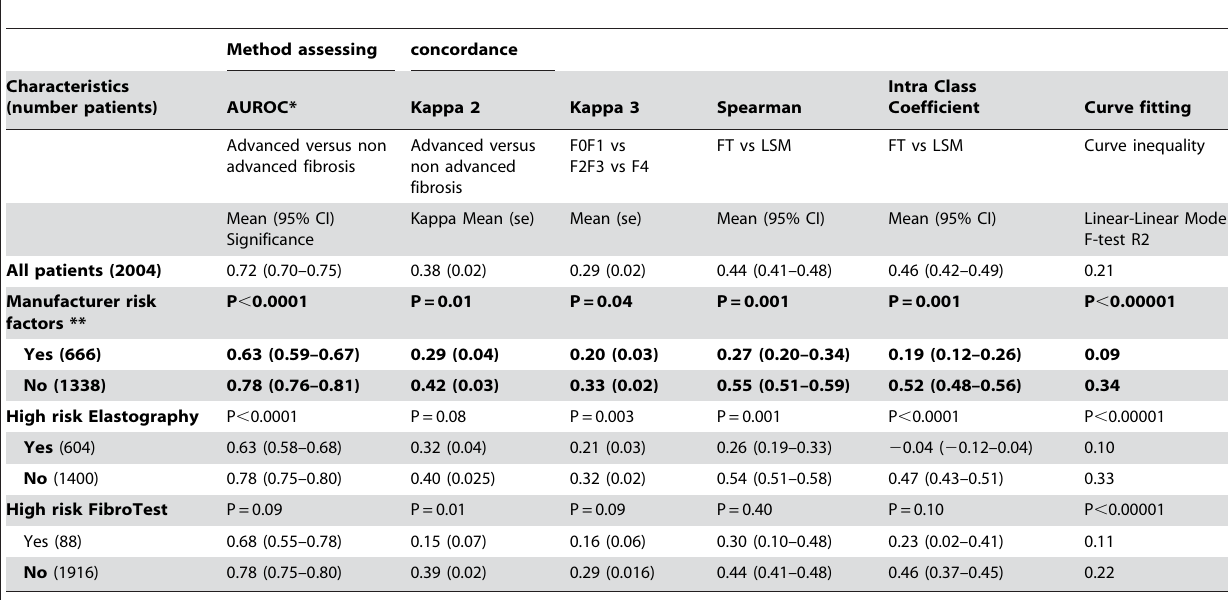
Table 2. Proof of concept: manufacturers’ risk factors of false positives/negatives are associated with strength of concordance between FibroTest (FT) and liver stiffness measurements (LSM).